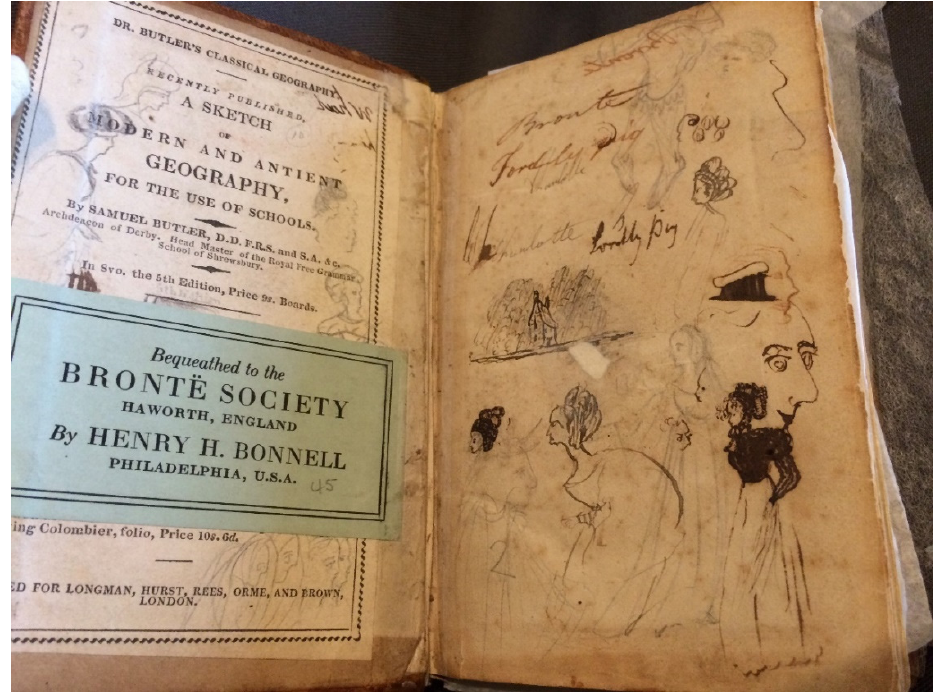
Figure 6. The Brontë family copy of Dr. Butler’s Classical Geography .